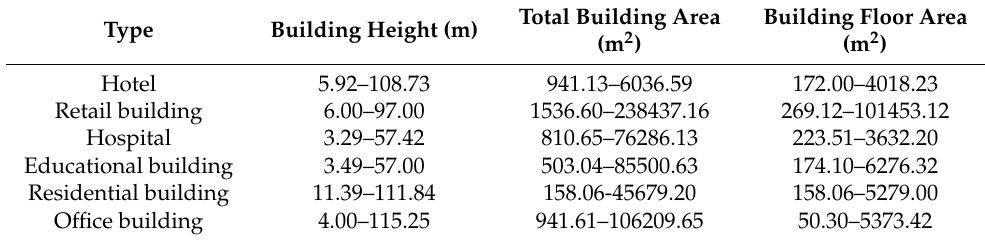
Table 1. The value range of parameters of selected buildings.